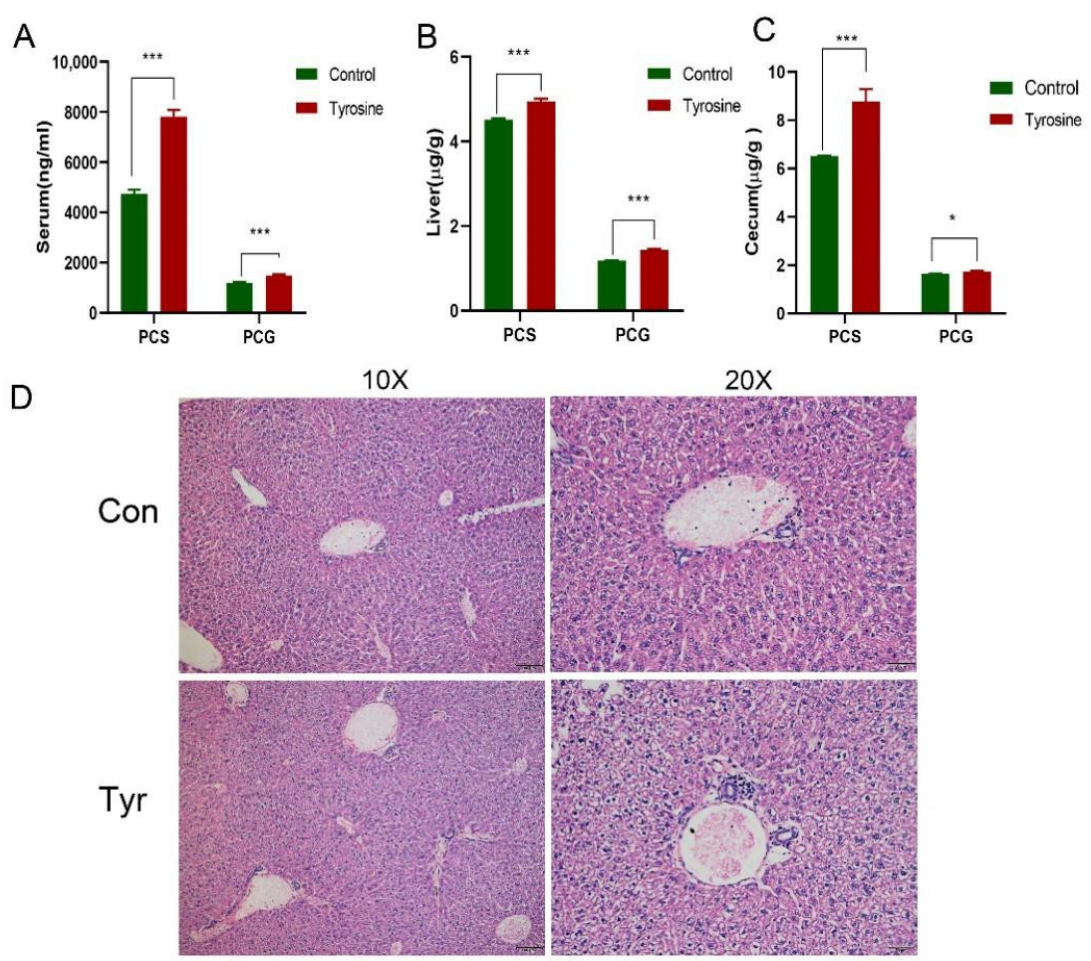
Figure 2. Tyrosine supplementation increases PCS and PCG concentrations. Increases in PCS and PCG concentrations in ( A ) serum, ( B ) liver, and ( C ) cecum. ( D ) PCS administration damages the liver of normal C57BL/6 female mice ( n = 10). * p < 0.05, *** p < 0.001.